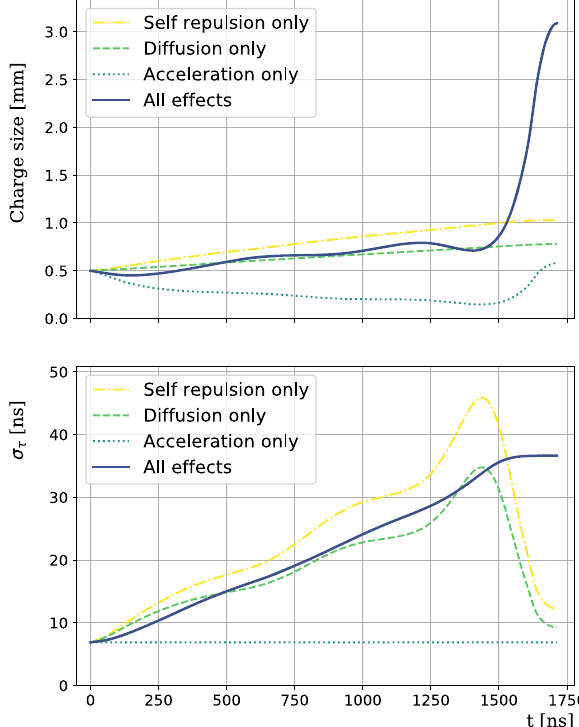
Fig. 2 Breakdown of the collective effects on a charge cluster. The top-left plot shows the drift velocity field of an IC detector with super- imposed in brown the drift path of the holes’ cluster for an interaction location marked by the star. The cluster’s drift velocity along the path